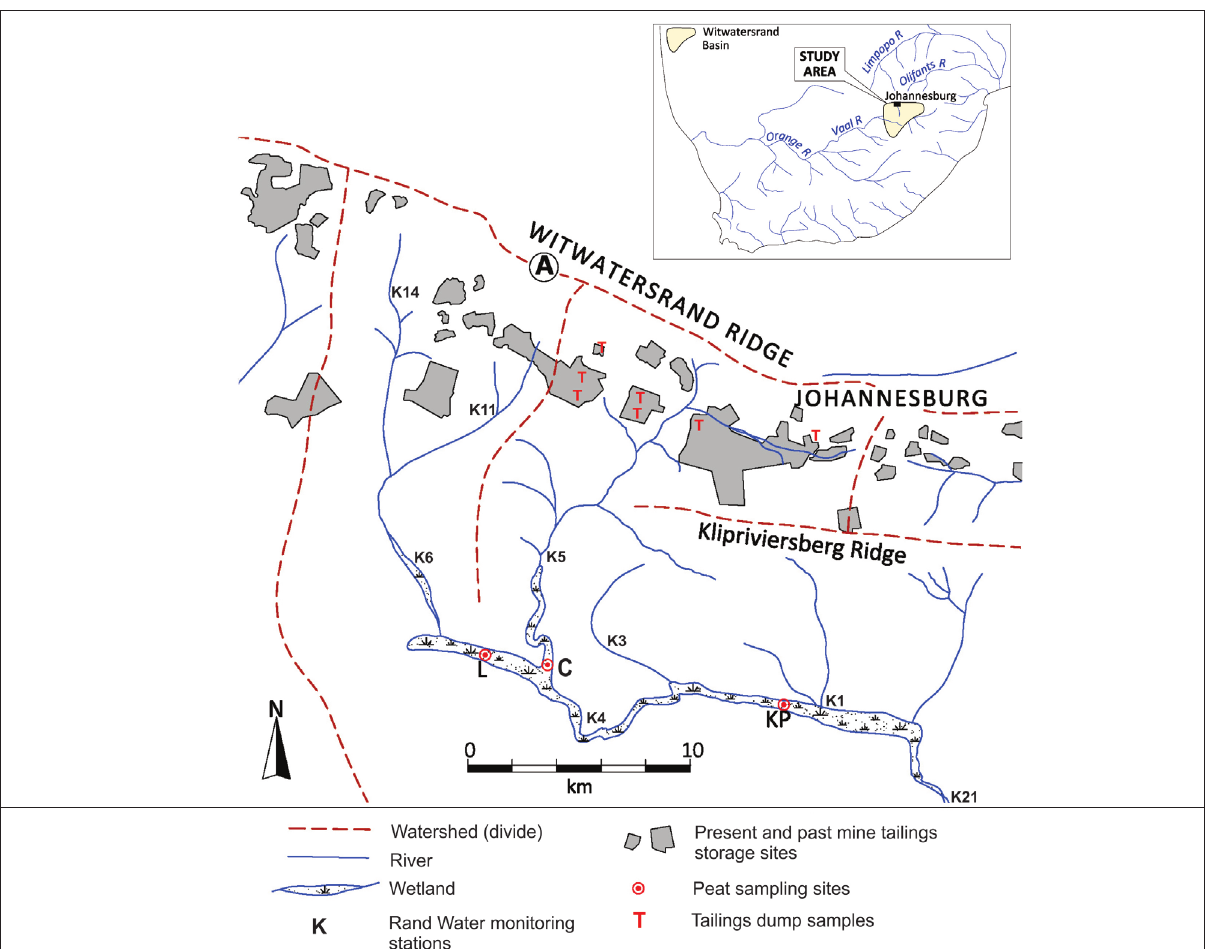
Map of the study area and location of the sampling sites in relation to mining activities in the Johannesburg